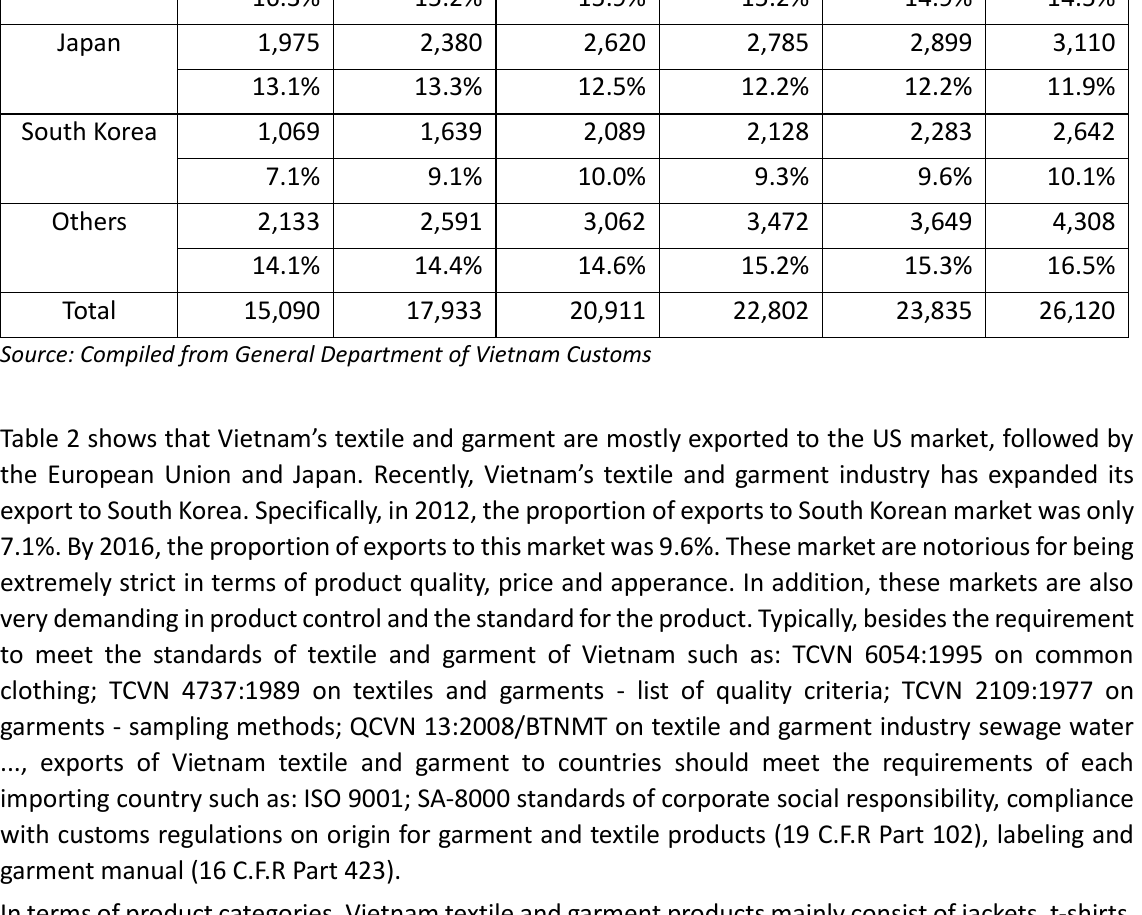
Table 2. Main export market of Vietnam’s textile and garment industry (2012 to 2017).